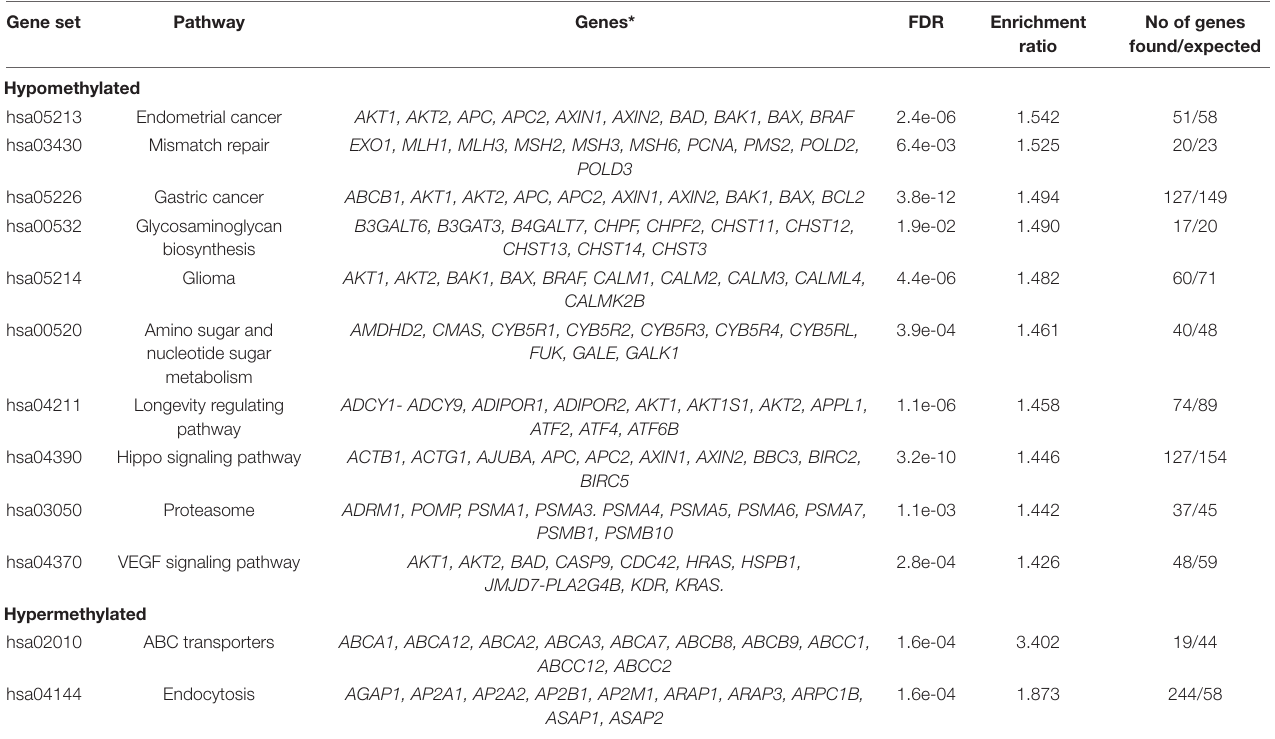
TABLE 2 | Summary of the pathway enrichment for hypomethylated and hypermethylated sites. Gene set Pathway Genes* FDR Enrichment